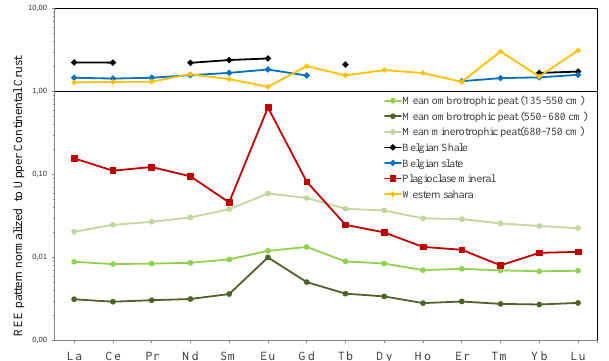
Fig. 7. REE average normalised to upper continental crust (UCC, Taylor and McLennan, 1985) and compared to those obtained from the western Sahara (Moreno et al., 2006), German snow profile (Black Forest, Aubert et al., 2006) and Belgian slate (Linnemann et al., 2012), Belgian shales (André et al., 1986), as well as to those obtained from plagioclase minerals collected in pan-African rocks (Laouni area, Cottin et al., 1998). The first group represents the mean REE UCC values of the Misten ombrotrophic section that oc- curs from 135 to 550cm (between 5550 calBP and 2000 calBP). The second group shows the transition zone from ombrotrophic to minerotrophic peat, from 550 to 680cm (between 6650 and 5550 calBP), and the third group represents the mean REE UCC values of the minerotrophic section occurs from 680 to 750cm (between 7300 and 6650